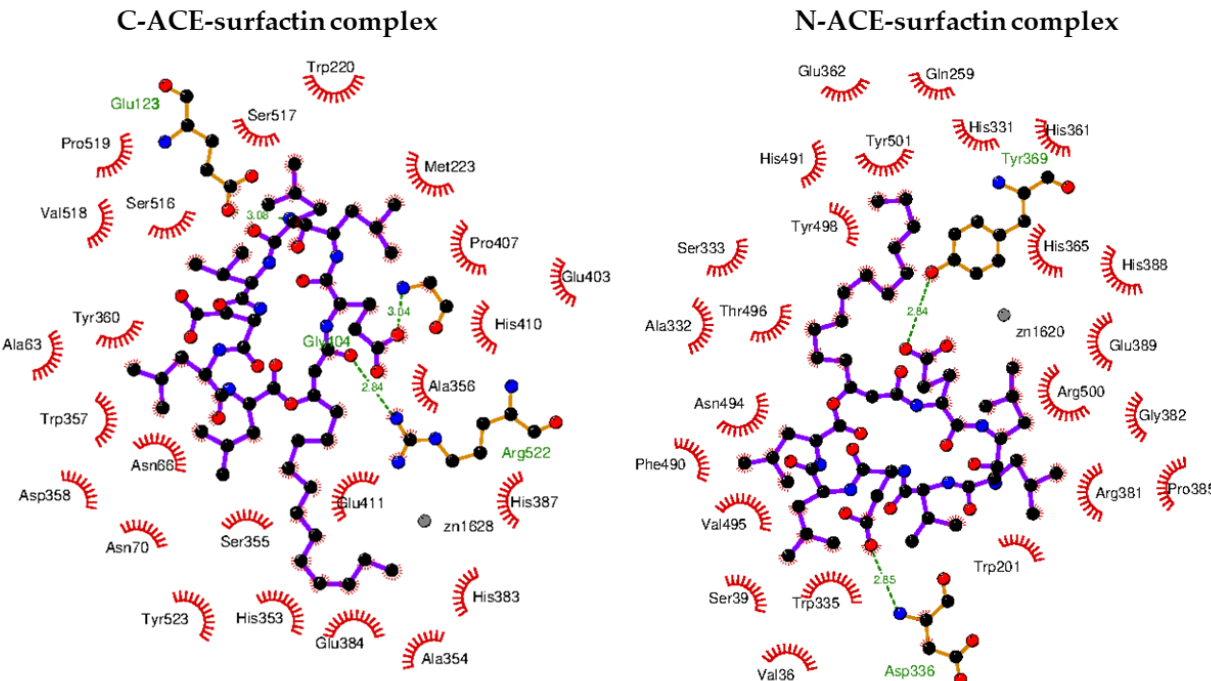
Figure 4. Binding mode of surfactin to C - ACE and N - ACE domains.